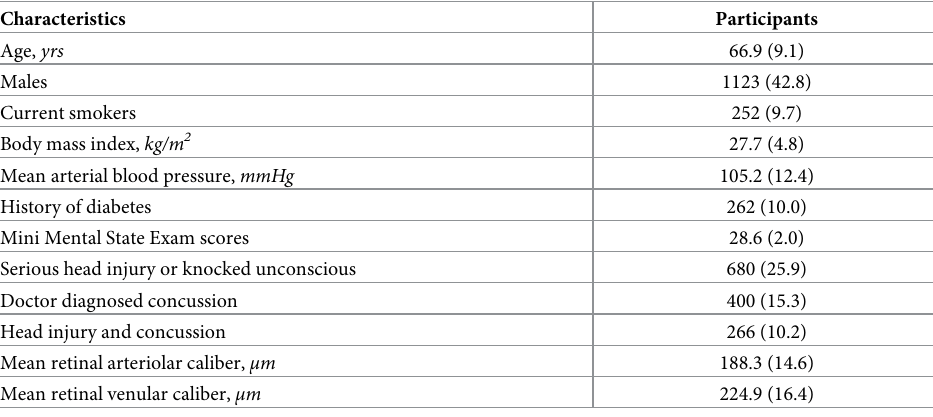
Table 1. Study characteristics of participants (n =